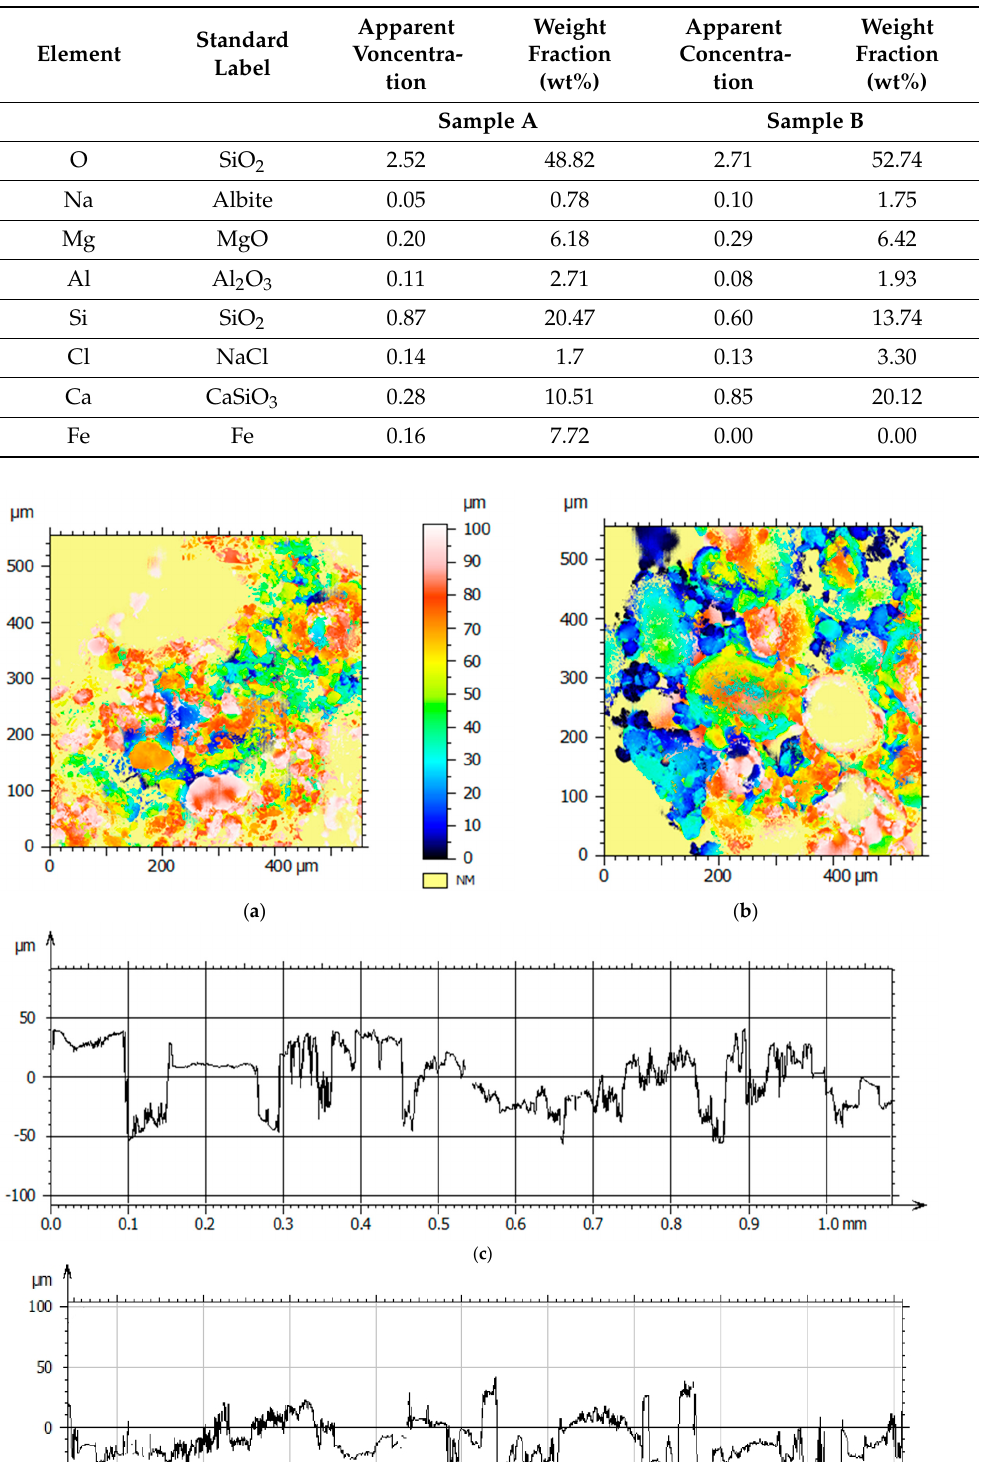
Table 4. Summary of the chemical compositions of tested soil samples.